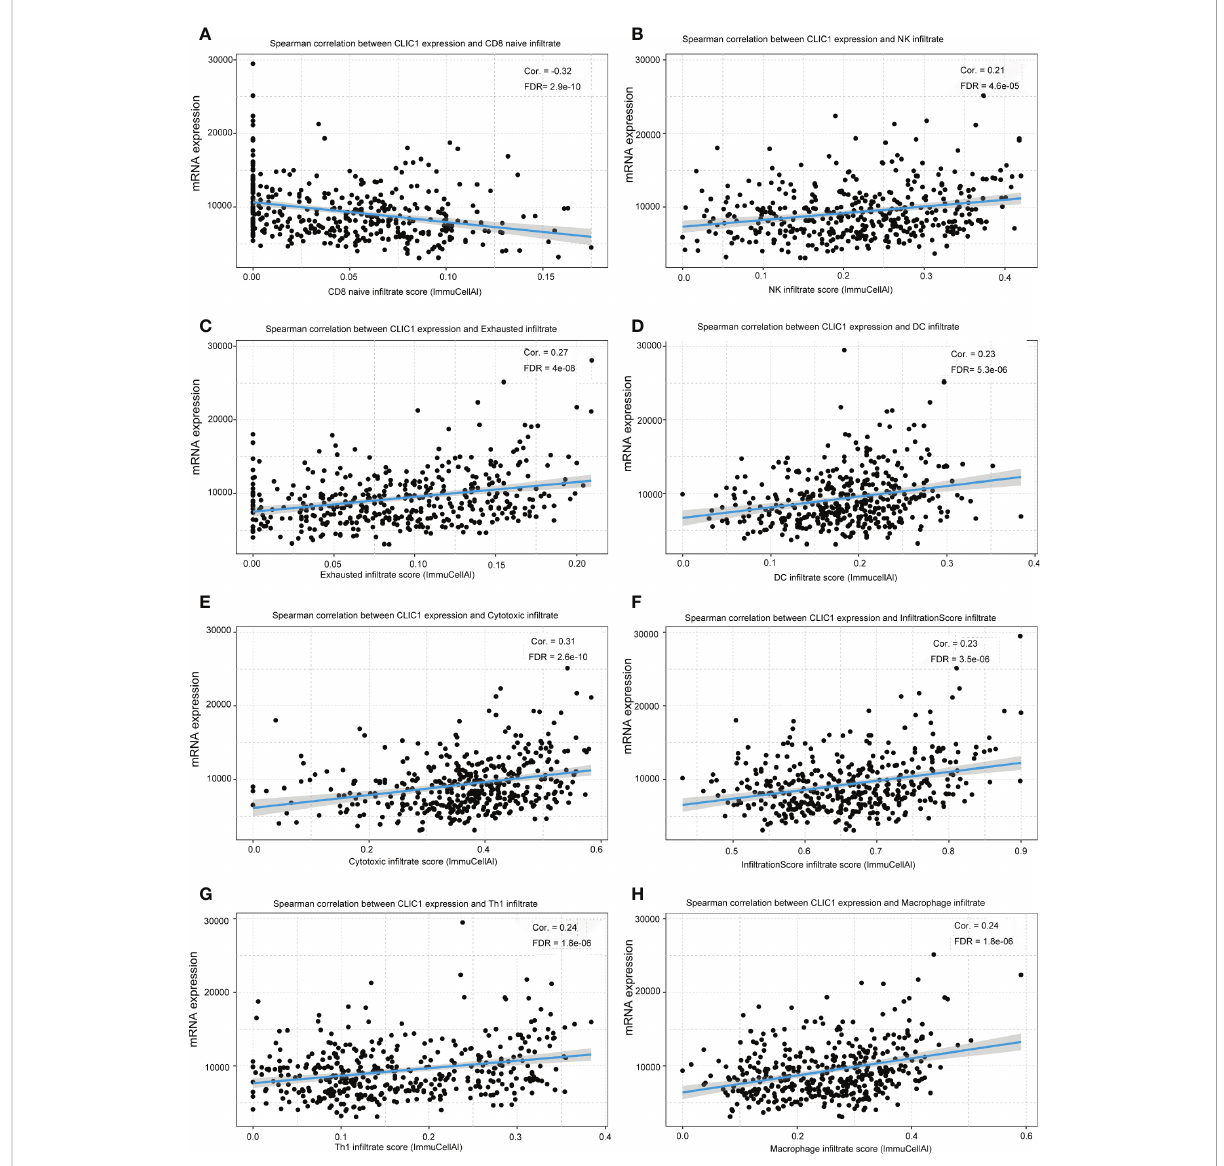
FIGURE 5 The relationship between CLIC1 and different immune cell in fi ltration levels. (A) Show that CLIC1 expression negatively correlates with CD8 naive in fi ltrate levels in bladder cancer. (B-H) A signi fi cant positive correlation is